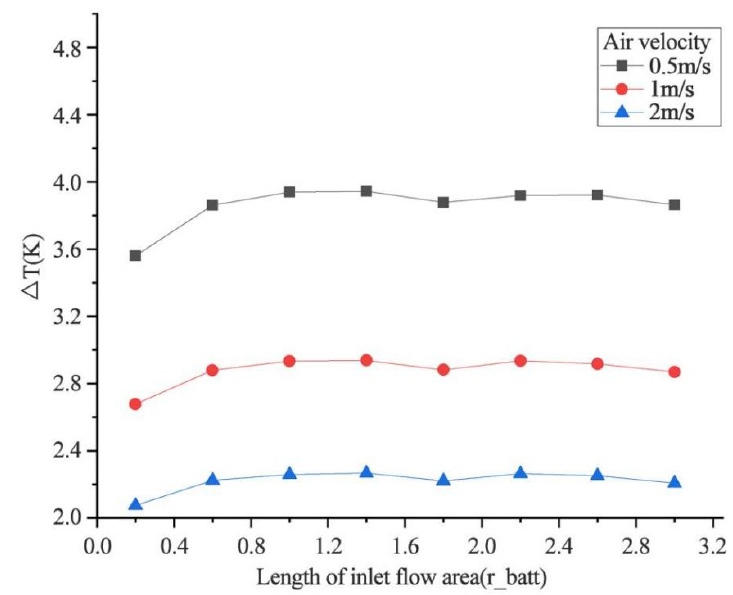
Figure 13. Average temperature changes of batteries at different inlet flow area size.